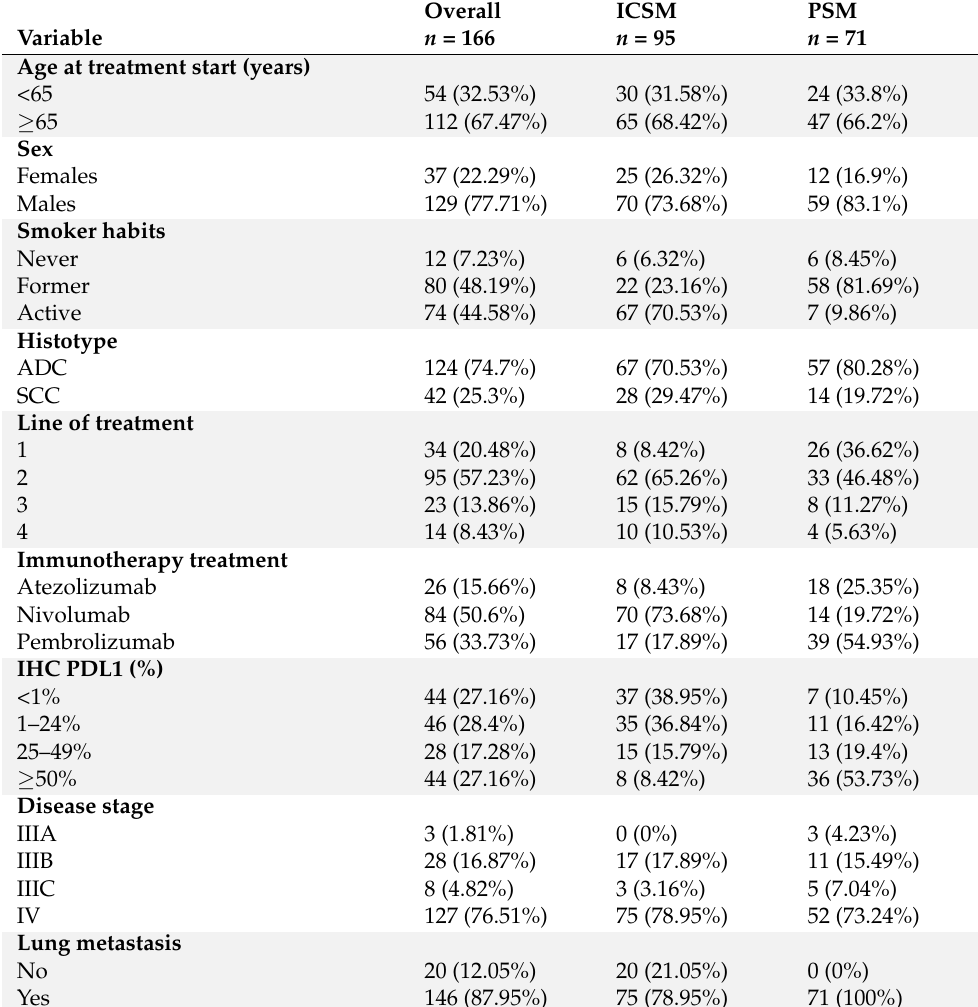
Table 1. Demographic and clinical characteristics of the analyzed cohorts. Variable = analyzed variable; Value = value that each categorical variable may assume; Overall = absolute and relative frequency (%) of categorical variables in the overall cohort; ICSM = absolute and relative frequency (%) of categorical variables in the ICSM cohort; PSM = absolute and relative frequency (%) of categorical variables in the PSM cohort; p = p -value from the Pearson chi-square test for independence between considered variables and cohorts (ICSM/PSM). # Including: soft tissues and adrenal